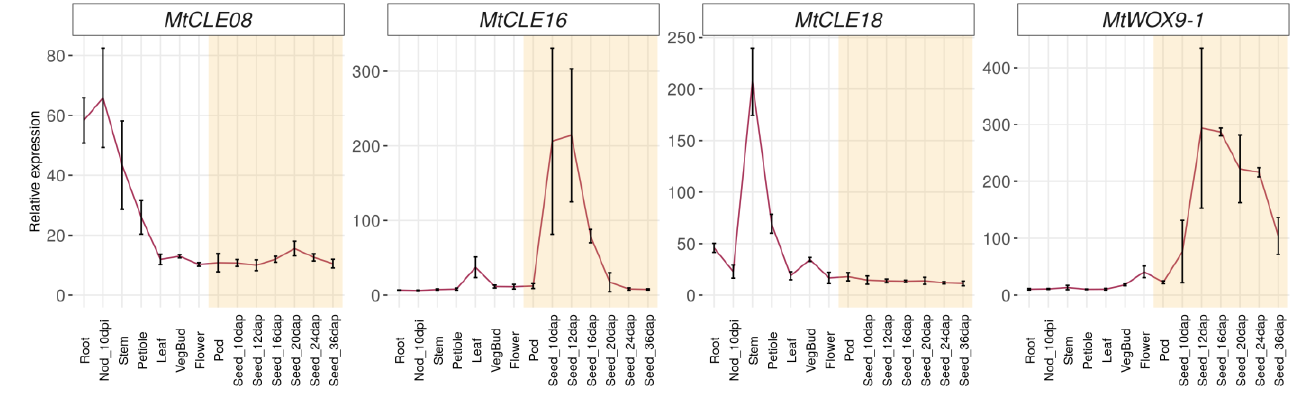
Figure 3. Expression patterns of MtCLE08 , MtCLE16 , MtCLE18 and MtWOX9-1 genes in different organs and during different stages of seed development according to the Medicago truncatula Gene Expression Atlas [21]. The error bars represent SD of three biological replicates. Stages of seed development are highlighted in yellow.